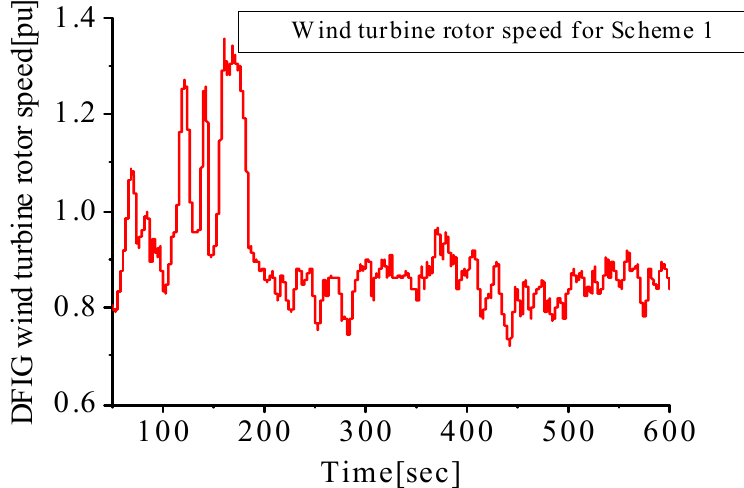
Figure 13. Wind turbine speed in wind farm A.